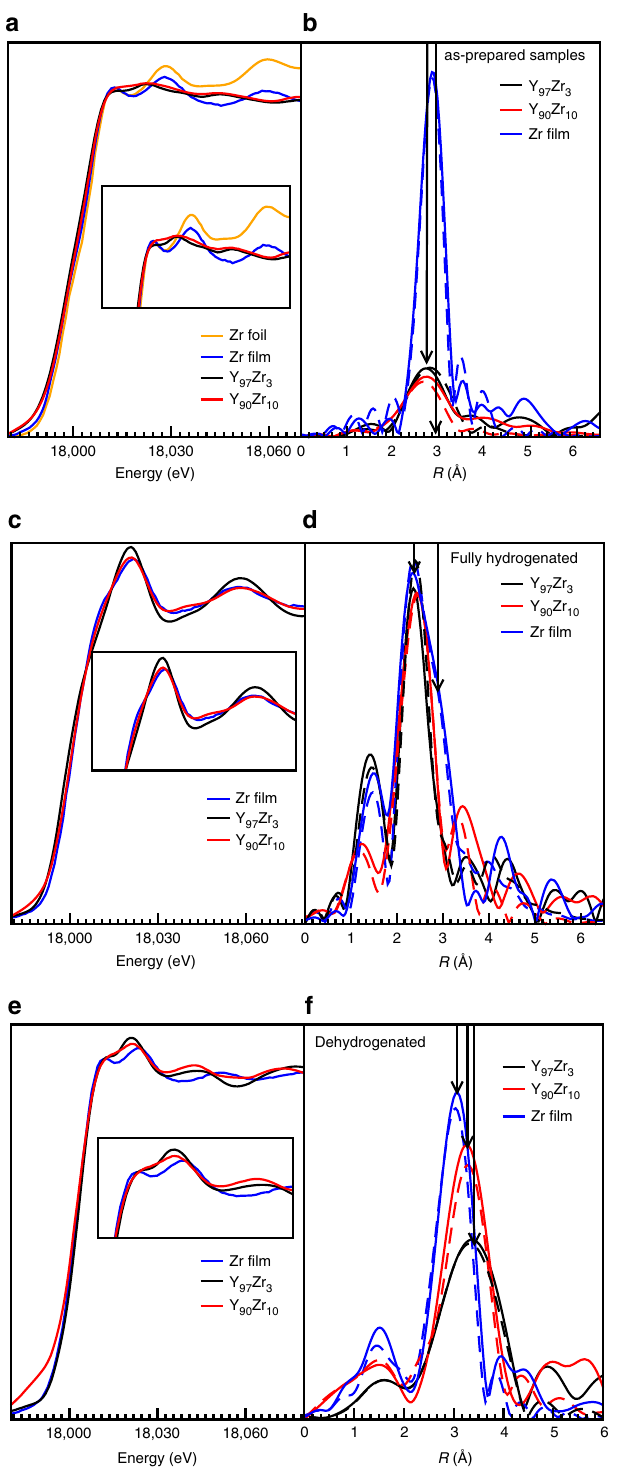
Fig. 3 Local structure analysis with XAS. XANES spectra of ( a ) the as- deposited, ( c ) fully hydrogenated, and ( e ) dehydrogenated thin fi lms. Phase uncorrected FT of the EXAFS spectra of the ( b ) as-deposited, ( d ) fully hydrogenated, and ( f ) dehydrogenated Zr and Y – Zr thin fi lms. The dashed lines are the fi ts of the EXAFS data, and the arrows are guides to the